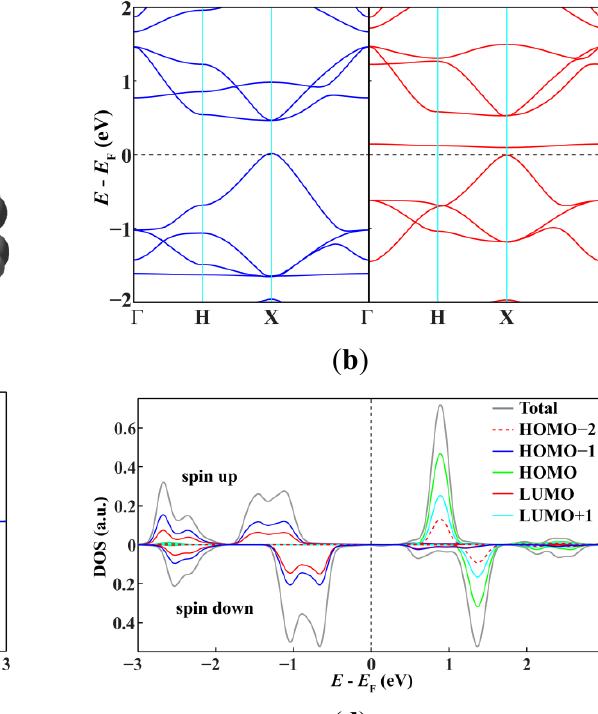
Figure 4. The optimized geometry structure of one unit cell ( a ) and the spin-resolved band structure ( b ) of the 2D MnPc sheet adsorbed with one CO molecule, and DOS projected onto the Mn 3d atomic orbitals ( c ) and frontier molecular orbitals of CO ( d